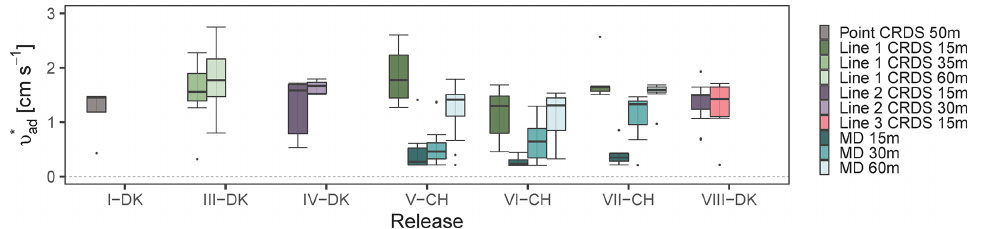
) required to have a recovery rate Q bLS /Q closest to one in all the ad